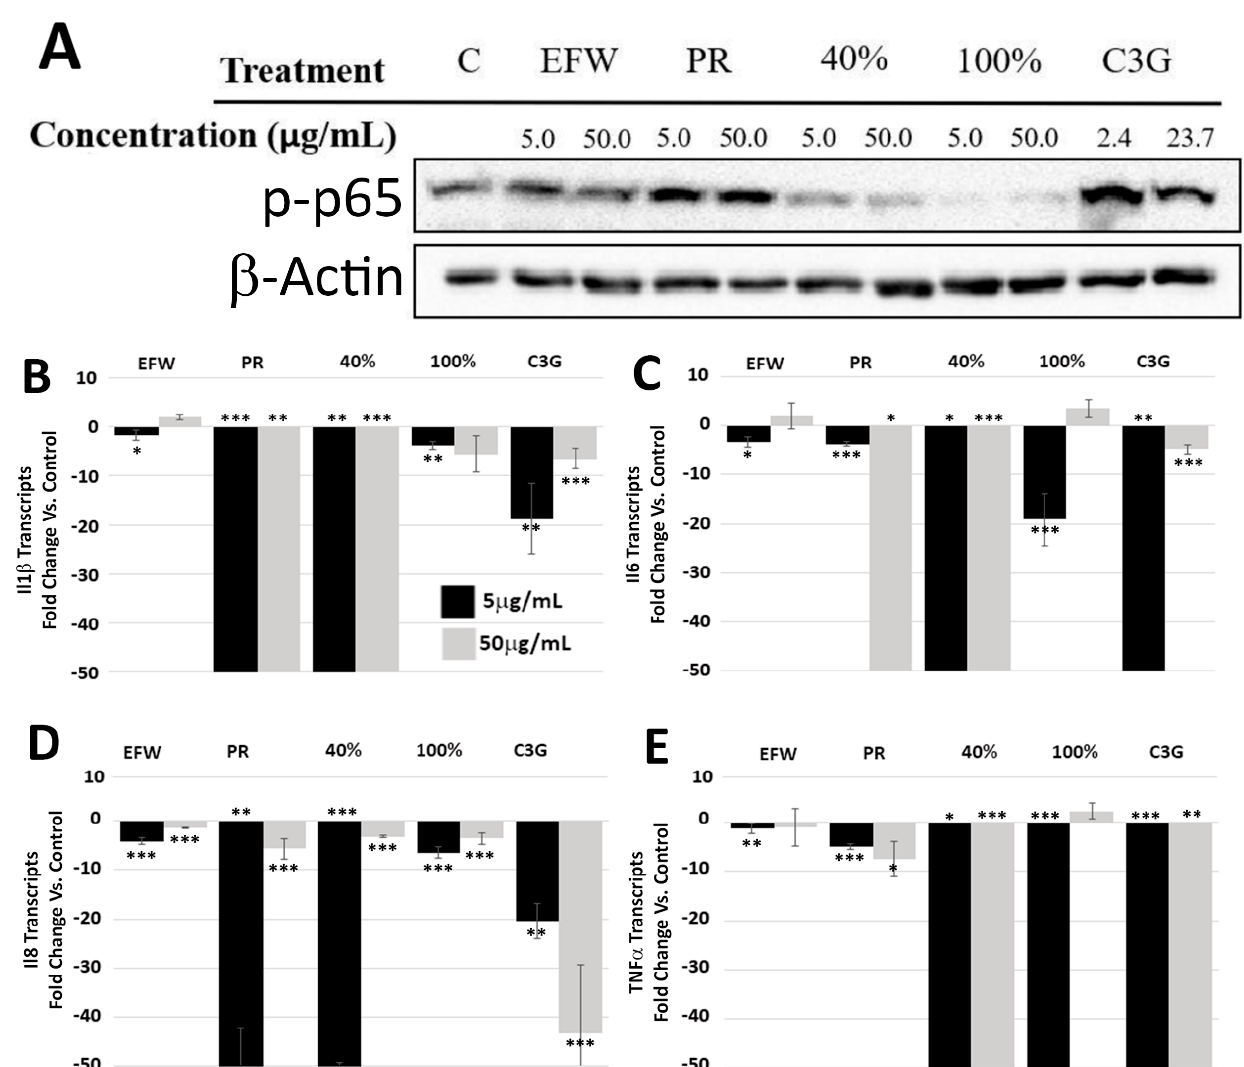
Figure 3. Specific Phenolics Fractions Reduce Levels of p65 Phosphorylation (p ‐ p65) in Normal Dermal Fibroblasts and Decrease Cytokine Transcripts. ( A ) 2DD cells were treated for 72h with two concentrations (5 μ g/mL or 50 μ g/mL) of haskap phenolic extractions and fractions followed by Western blot analysis for p ‐ p65 (top panel) and load control, β‐ actin (bottom panel). C—control, EFW—ethanol:formic acid:water, PR—phenolic rich, 40%—40% ethanol fraction, 100%—100% ethanol fraction. NOTE—this is one representative Western blot of two biological replicates quantified in Supplemental material Figure S3. qRT-PCR was used to probe cDNA libraries for Il1 β ( B ), Il6 ( C ), Il8 ( D ) and TNF α ( E ) from 2DD cells exposed to 5 µ g/mL (black bars) and 50 µ g/mL (grey bars) of EFW, PR, 40% and 100% phenolic fractions as well as C3G (2.4 µ g/mL and 23.75 µ g/mL). Graph values were cut off after 50-fold changes. p -values = * p < 0.10, ** p < 0.05, *** p < 0.01 NOTE: quantified values are shown in Supplemental material Table S4.